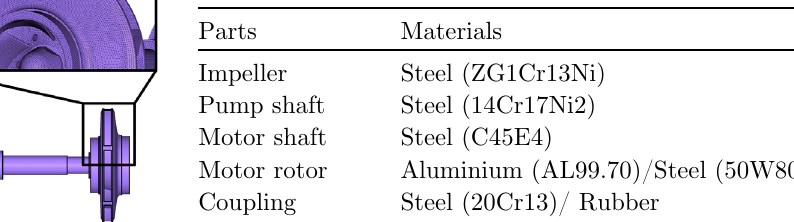
Fig. 10. The fi rst 3 order mode of the centrifugal pump shaft system. (a) The fi rst mode shape of the shaft (natural frequency: 140.66 Hz); (b) the second mode of the shaft (natural frequency: 419.31Hz); (c) the third mode of the shaft (natural frequency: 857.20 Hz). Table 4. Materials of various parts in the centrifugal pump